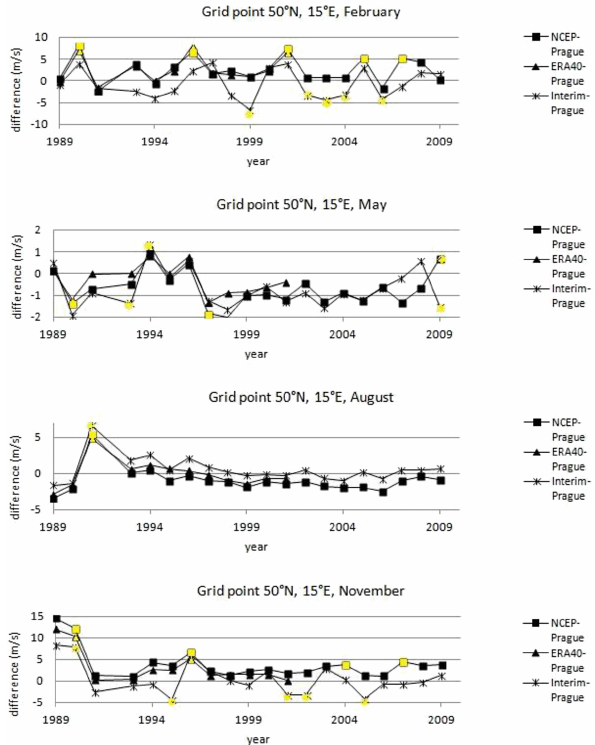
Fig. 5. Differences in February, May, August and November aver- age wind speeds between reanalysis at grid point 50 ◦ N (ERA-40, NCEP) or 49.5 ◦ N (ERA-Interim), 15 ◦ E and Prague-Libus station (50 ◦ N, 15 ◦ E) at 10hPa. Yellow full circles mean differences sta- tistically significant at 95%